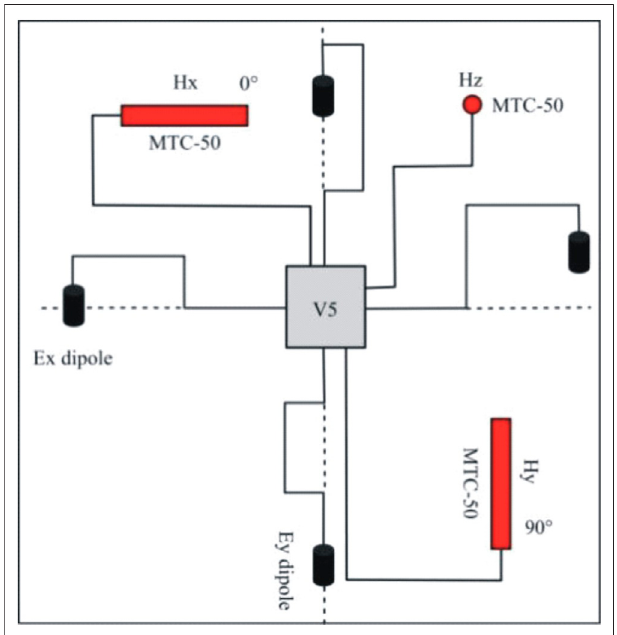
FIGURE 3 | Diagram of the MT station layout in the Jizhong